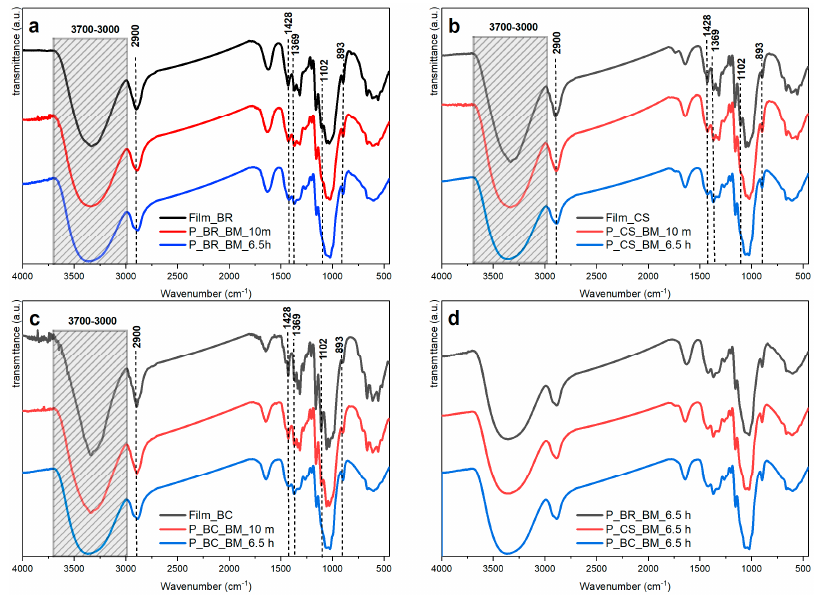
Figure 3. Infrared spectra of cellulose samples: ( a ) banana rachis (BR) milled at 10 min (P_BR_BM_10 m) and 6.5 h (P_BR_BM_6.5 h), and unmilled (Film BR); ( b ) commercial sample (CS) milled at 10 min (P_CS_BM_10 m) and 6.5 h (P_CS_BM_6.5 h), and unmilled (Film CS); ( c ) bacterial cellulose (BC) milled at 10 min (P_BC_BM_10 m) and 6.5 h (P_BC_BM_6.5 h), and unmilled (Film BC); and ( d ) BR, CS, and BC samples at 6.5 h milling time .